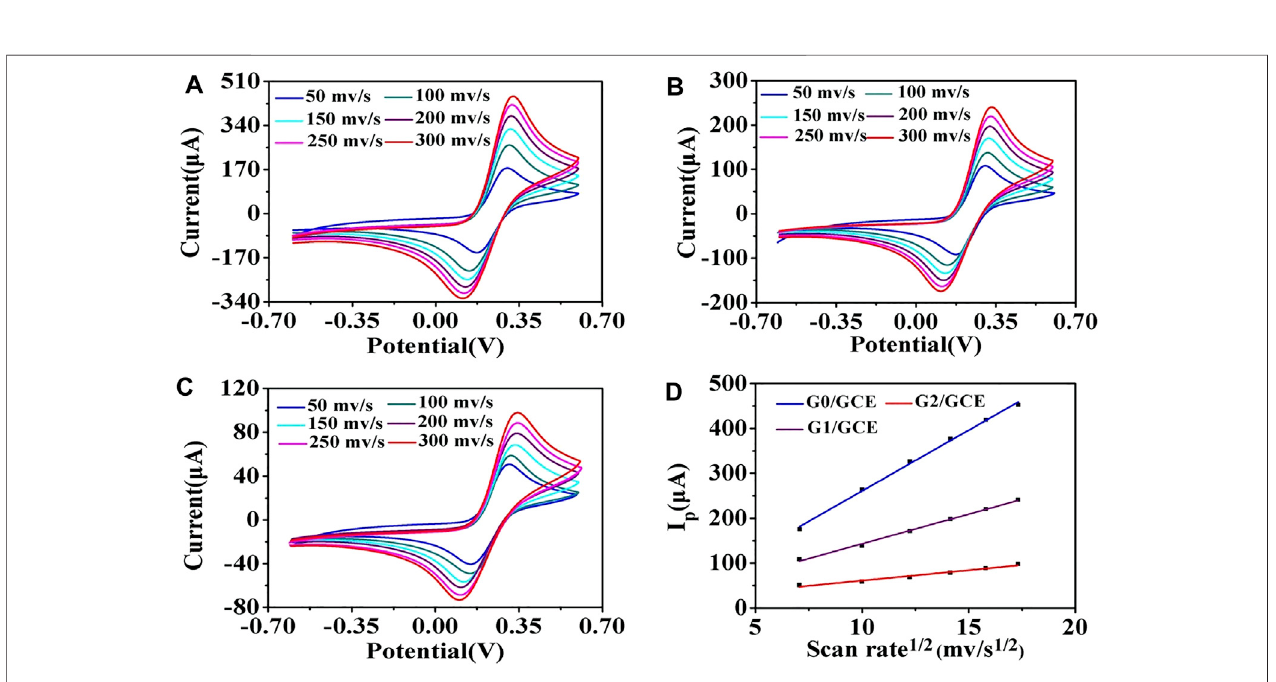
Frontiers in Bioengineering and Biotechnology |